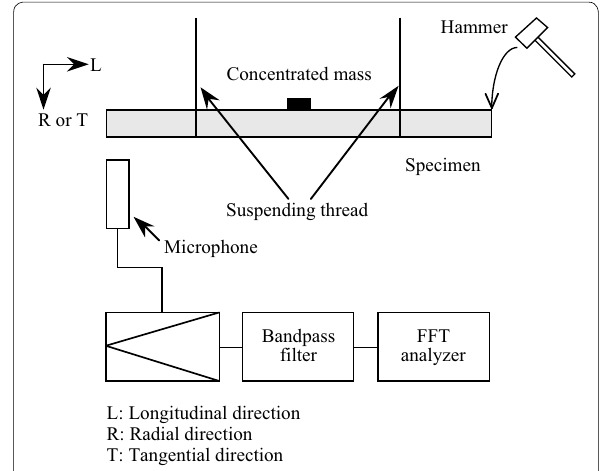
Fig. 2 Schematic diagram of the experimental setup for the bending vibration tests